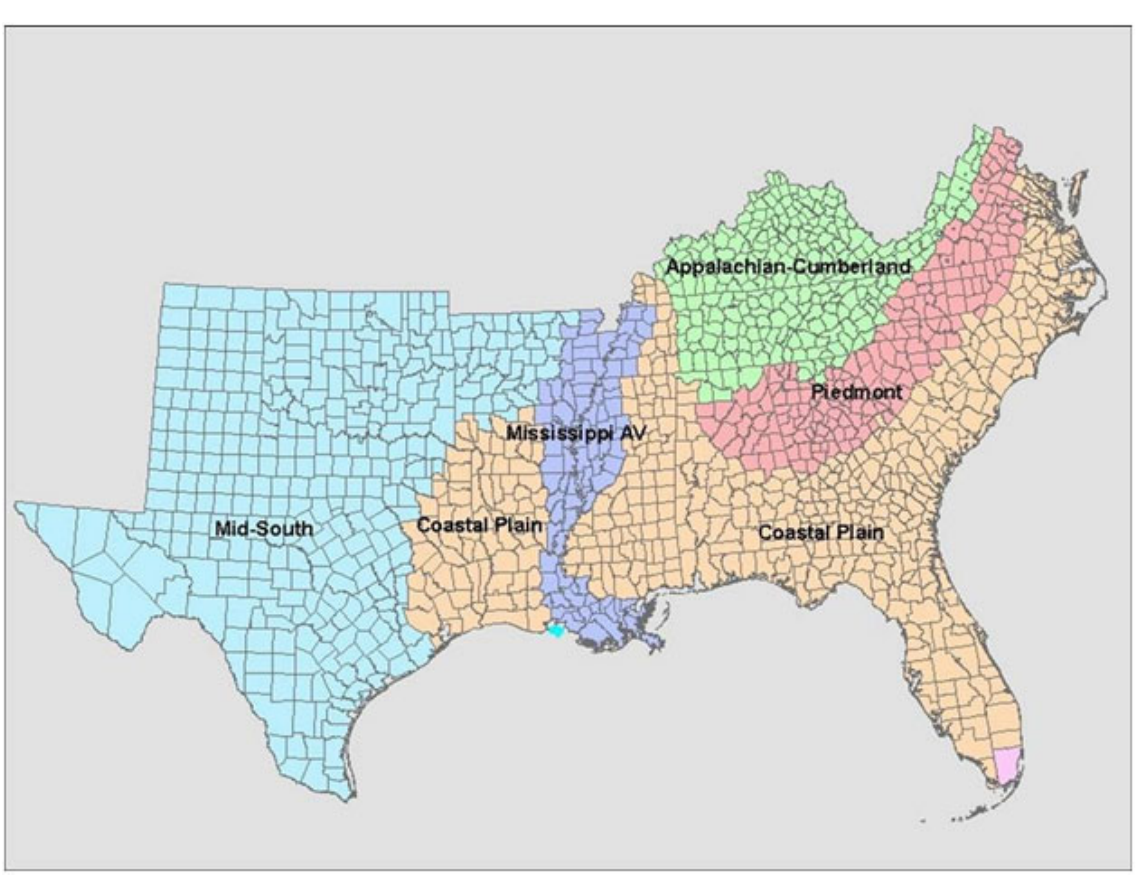
Figure 1. Southern